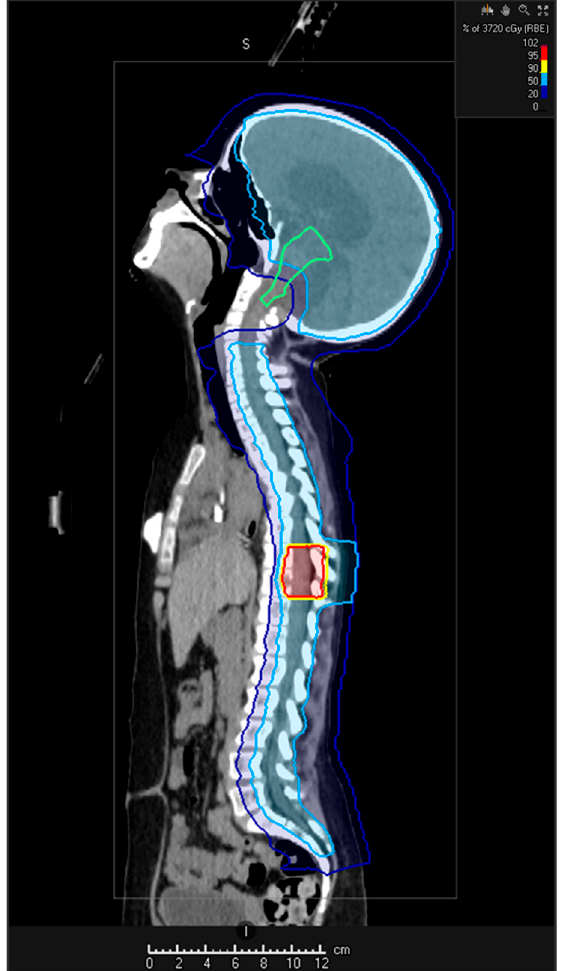
Figure 4. Re-irradiation for a rMB with a metastatic relapse. Second CSI (18 Gy) delivered with spinal boost (37.2 Gy). Integrated sparing of craniocervical junction and lower brainstem (green line) to avoid cumulative, intolerable doses. Initial CSI comprised 23.4 Gy with posterior fossa boost (54 Gy). Coloured areas reflect the CSI and boost volumes with respective doses displayed in the colour bar (top right